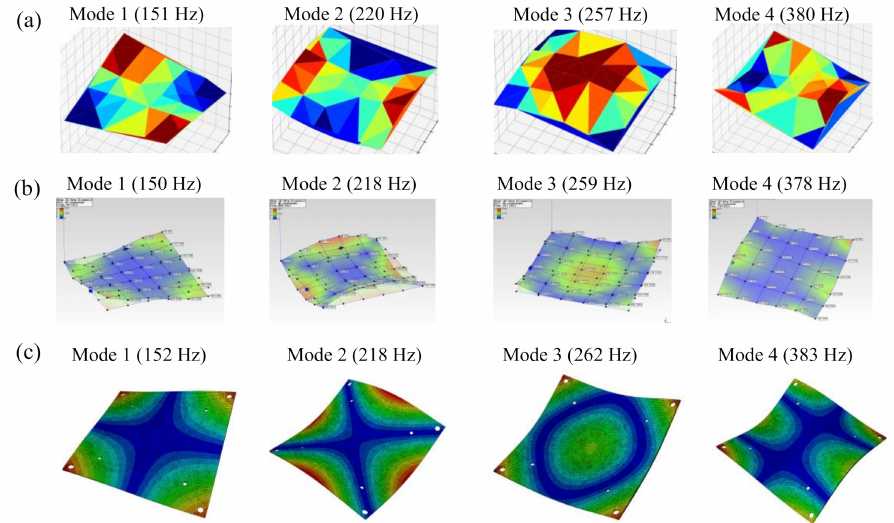
Figure 9. Natural frequencies and mode shapes of the load-carrying plate: ( a ) operational mode shapes with corresponding natural frequencies measured by the 3DPT method, ( b ) mode shapes with corresponding natural frequencies measured by the roving hammer method, ( c ) modal parameters obtained by the finite element analysis (FEA)